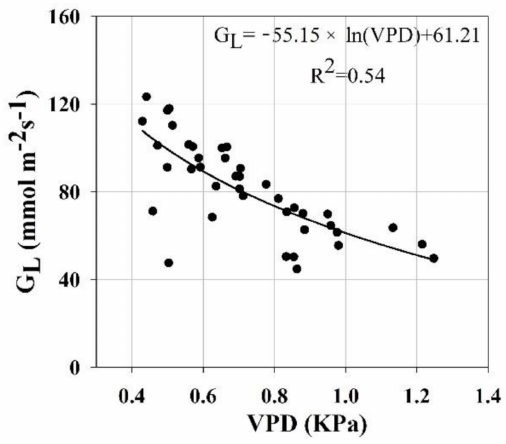
Figure 8. Plot exhibiting the relationship between VPD and canopy conductance. Note that the data were excluded on rainy days and when VPD < 0.4